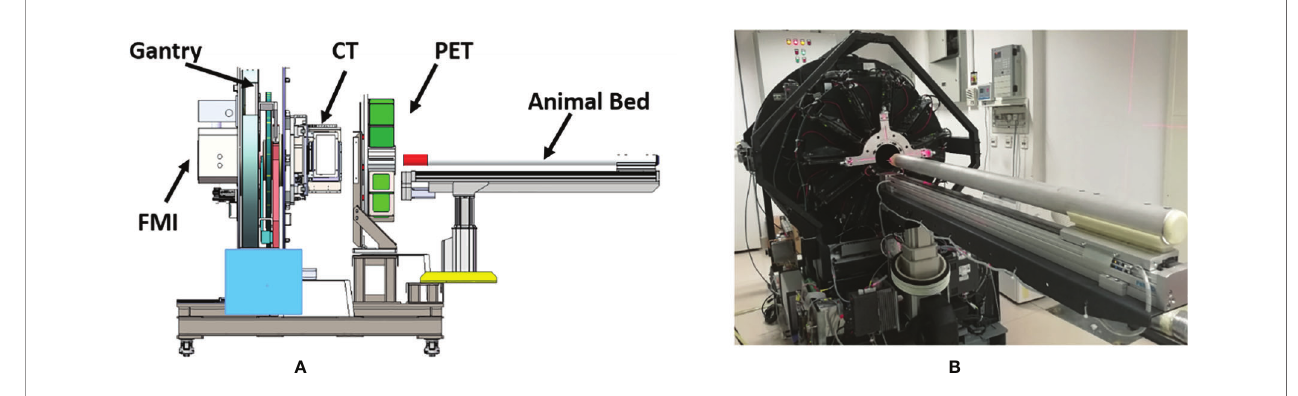
FIGURE1 | (A) Schematic representation of the tri-modality imaging system. (B) The actual appearance of the tri-modality